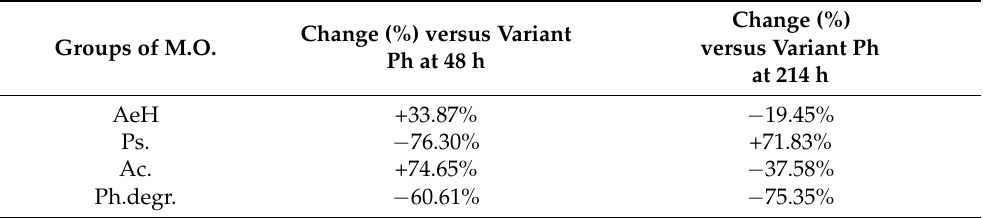
Table 3. Effect of ND on the amount of culturable key groups of microorganisms at 48 h and 214 h of the bioremediation process (expressed in